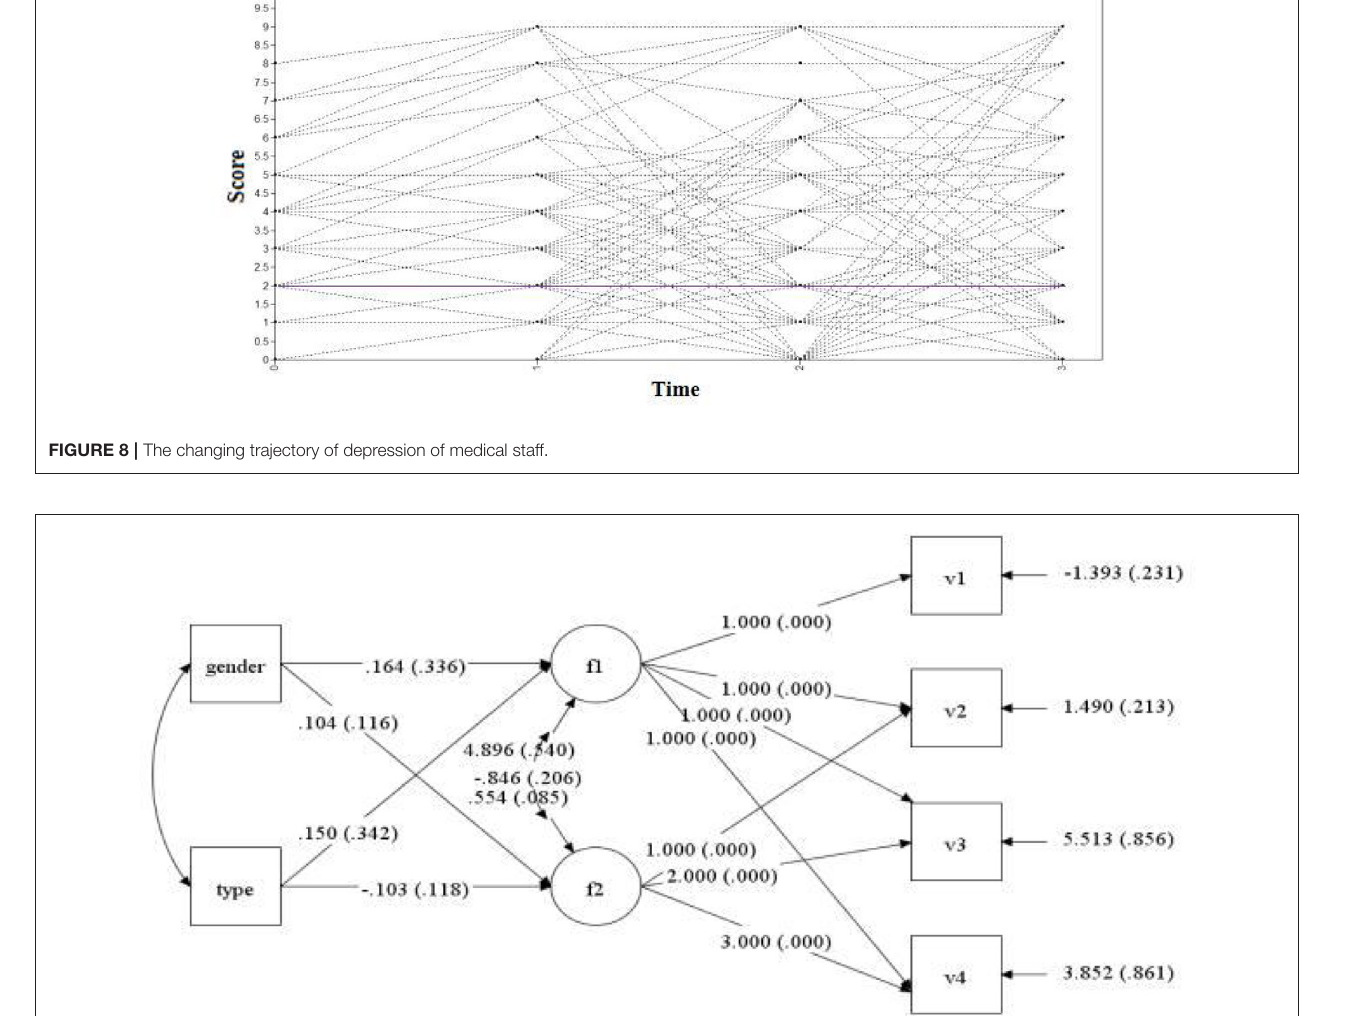
FIGURE 9 | Path of latent variable growth curve model of depression in the medical staff. distinctions in mental health levels and growth rates of medical staff